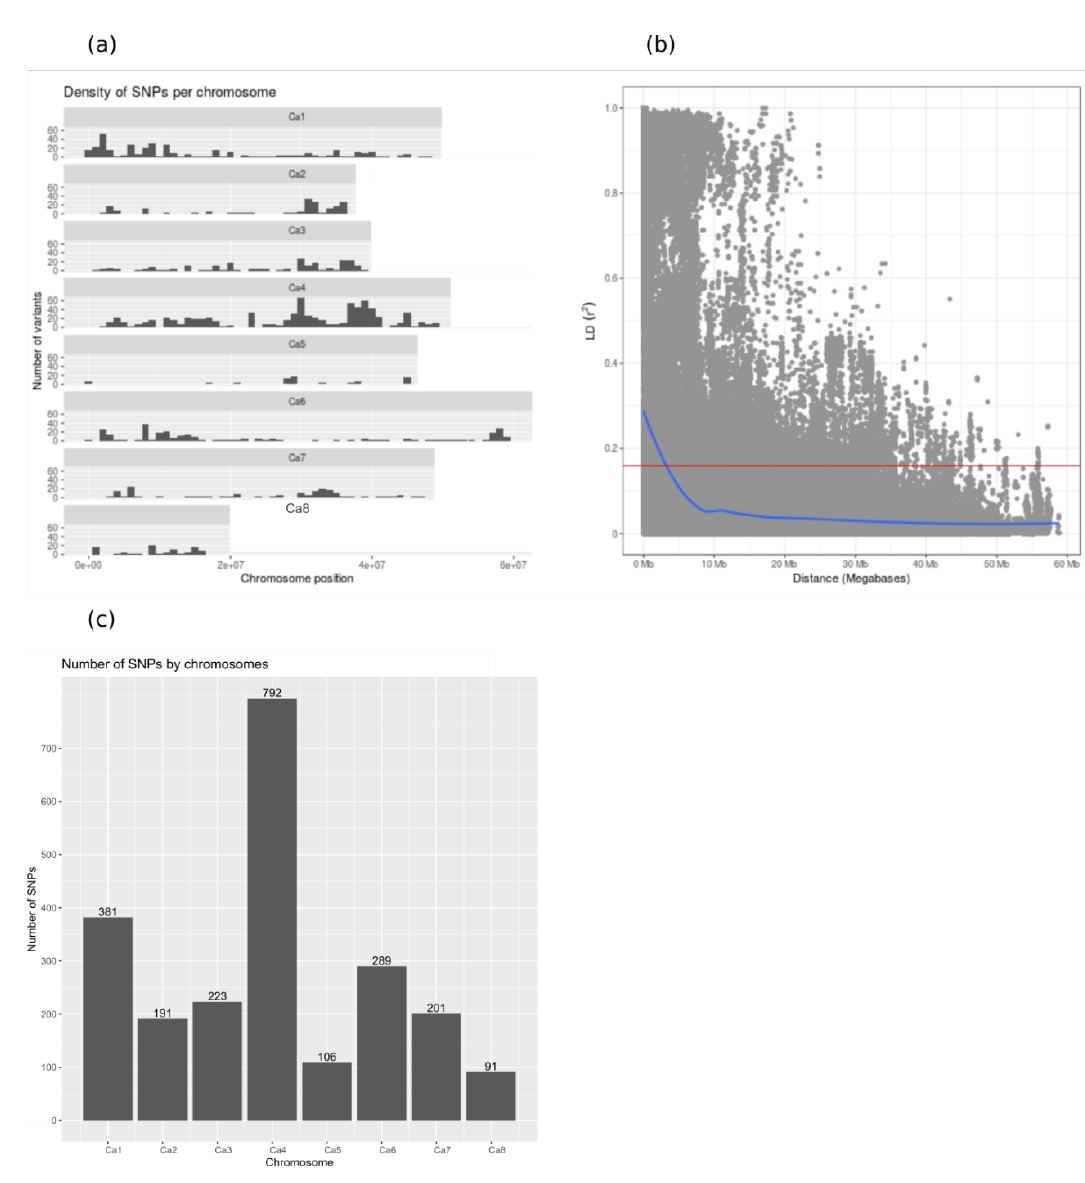
Figure 3. ( a ) Density of SNPs across the chickpea genome. Chromosome Ca6 is the longest chromosome in the chickpea genome (59.46 Mb) and chromosome Ca8 is the shortest (16.48 Mb). ( b ) Linkage disequilibrium (LD) (r 2 ) plots of the whole chickpea genome. The horizontal red line indicates the 95th percentile of the distribution of the unlinked r 2 , which gives the critical value of r 2 . ( c ) Distribution of SNPs along the eight chromosomes of the chickpea genome.